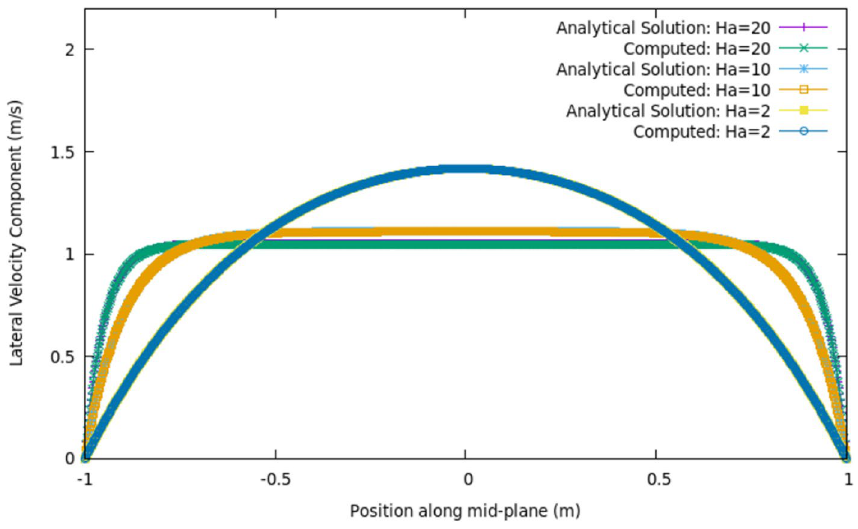
Figure 1. Analytical solution and numerically computed solution to Hartmann flow problem, at t = 2